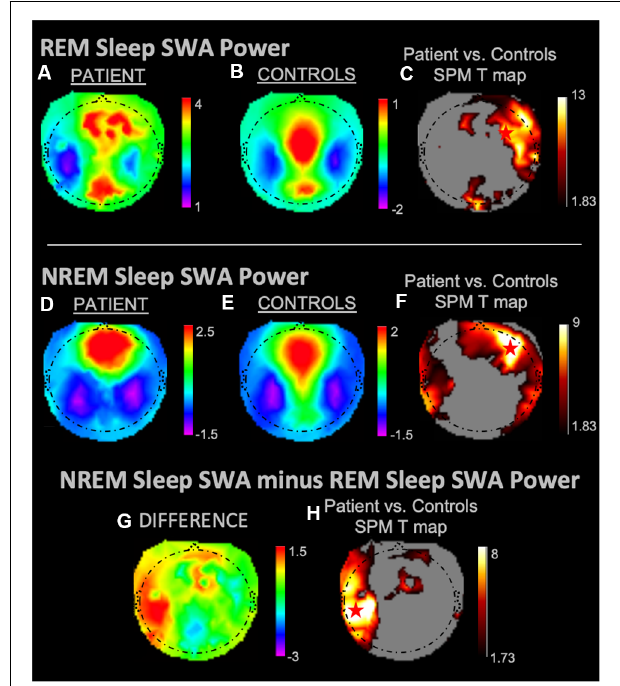
FIGURE 1 | Slow-wave activity (SWA) power topographies for the patient and controls during REM sleep and non-rapid eye movement (NREM) sleep taken in isolation, and for intrasubject NREM sleep subtracted by REM sleep. Red stars denote SWA maximums. REM sleep and NREM sleep in isolation displayed SWA maxima in the right frontal areas. We observed a left fronto-temporal NREM sleep SWA maximum as referenced to intrasubject REM sleep SWA. (A) REM sleep mean SWA power for the patient. (B) REM sleep mean SWA power for controls. (C) Statistical Parametric Mapping (SPM) T map for the statistical difference between patient and controls REM sleep SWA; the red star shows the SWA maximum. (D) NREM sleep mean SWA power for the patient. (E) NREM sleep mean SWA power for controls. (F) SPM T map for the statistical difference between patient and controls NREM sleep SWA; the red star shows the SWA maximum. (G) Difference between patient and controls NREM sleep SWA subtracted by REM sleep SWA. (H) SPM T map for the difference between patient and controls SWA power during NREM sleep subtracted by REM sleep SWA; the red star shows the SWA maximum. Each T map pictured above is thresholded for a display of uncorrected p < 0.05. The rainbow color scale is utilized for regression slope values and the hot color scale for t